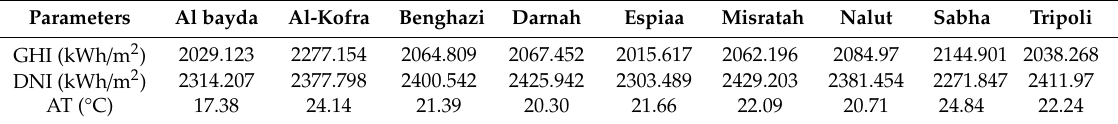
Table 7. Annual mean GHI, DNI, and AT for all selected